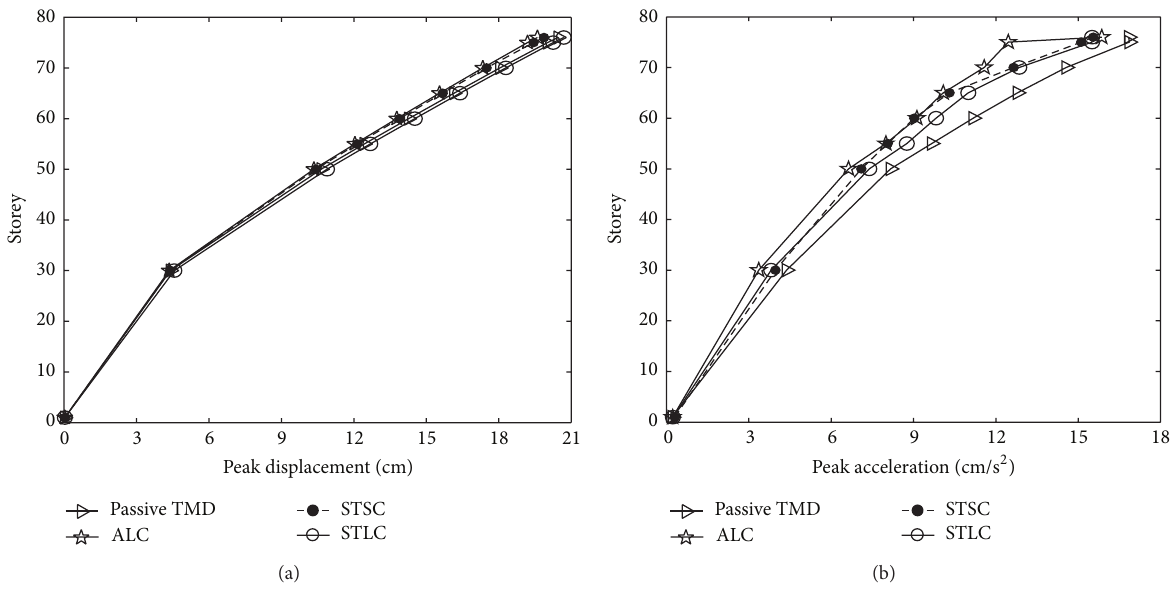
Figure 9: Comparison of peak displacement and peak acceleration ( 15 % stiffness variation).